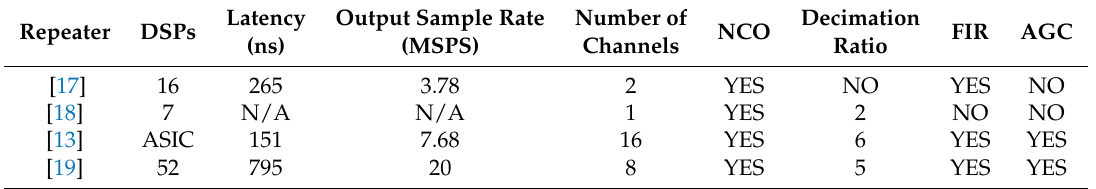
Table 2. Properties and specifications of Field Programmable Gate Array (FPGA)-based repeaters.